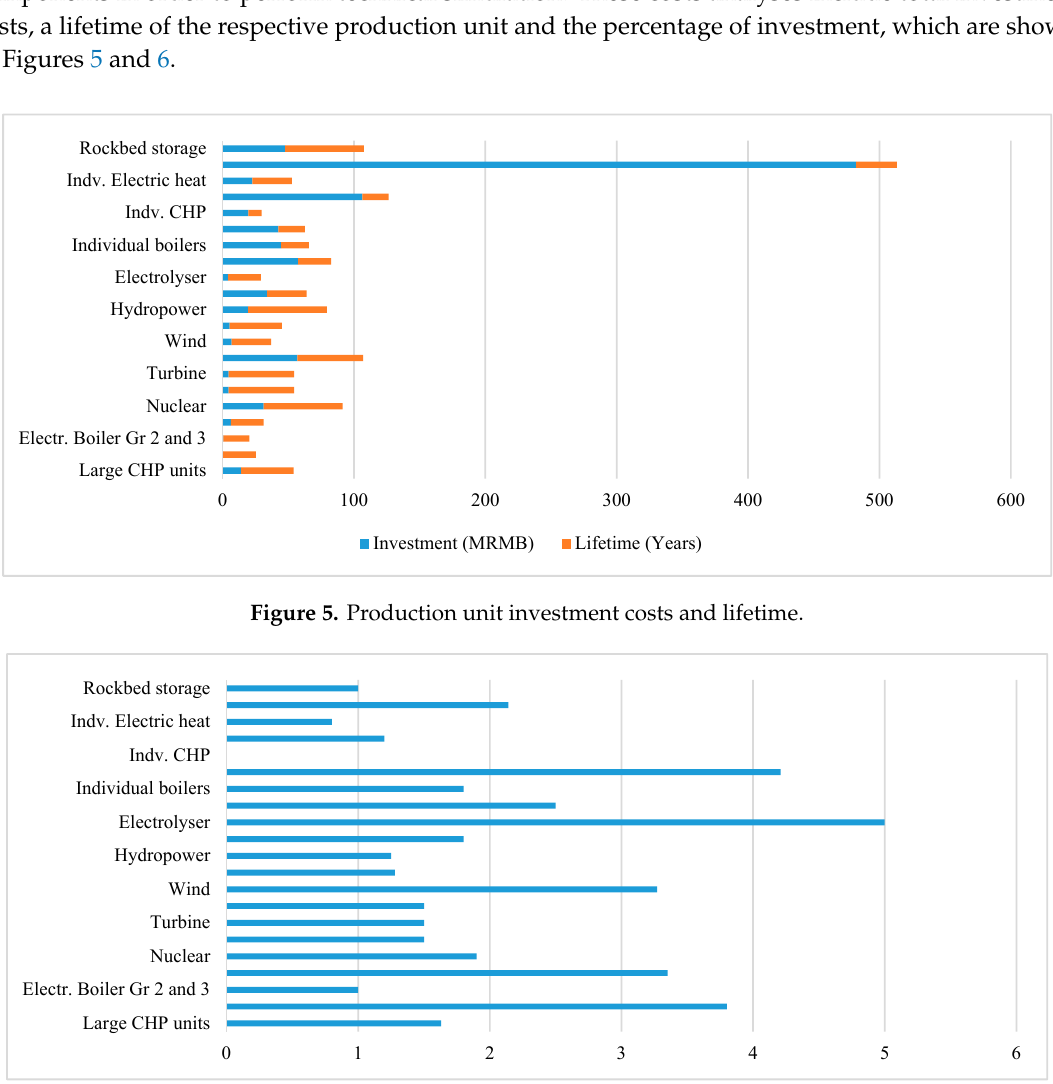
Figure 6. Production unit percentage of investment costs.